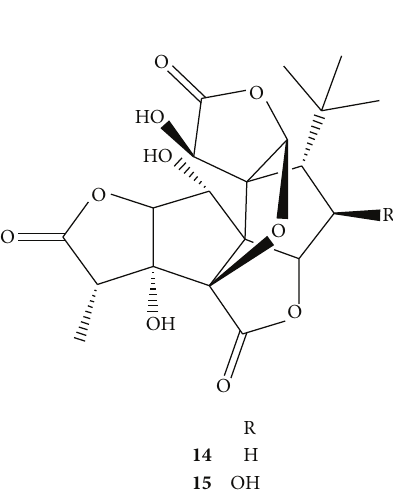
Figure 2: Structure of